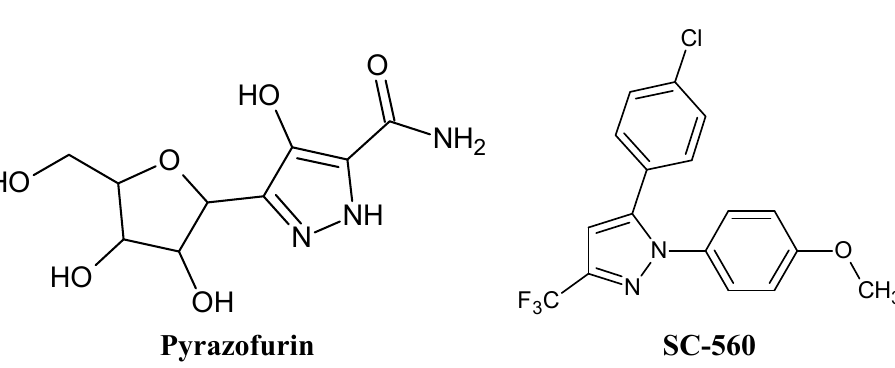
Figure 1. Pyrazofurin and